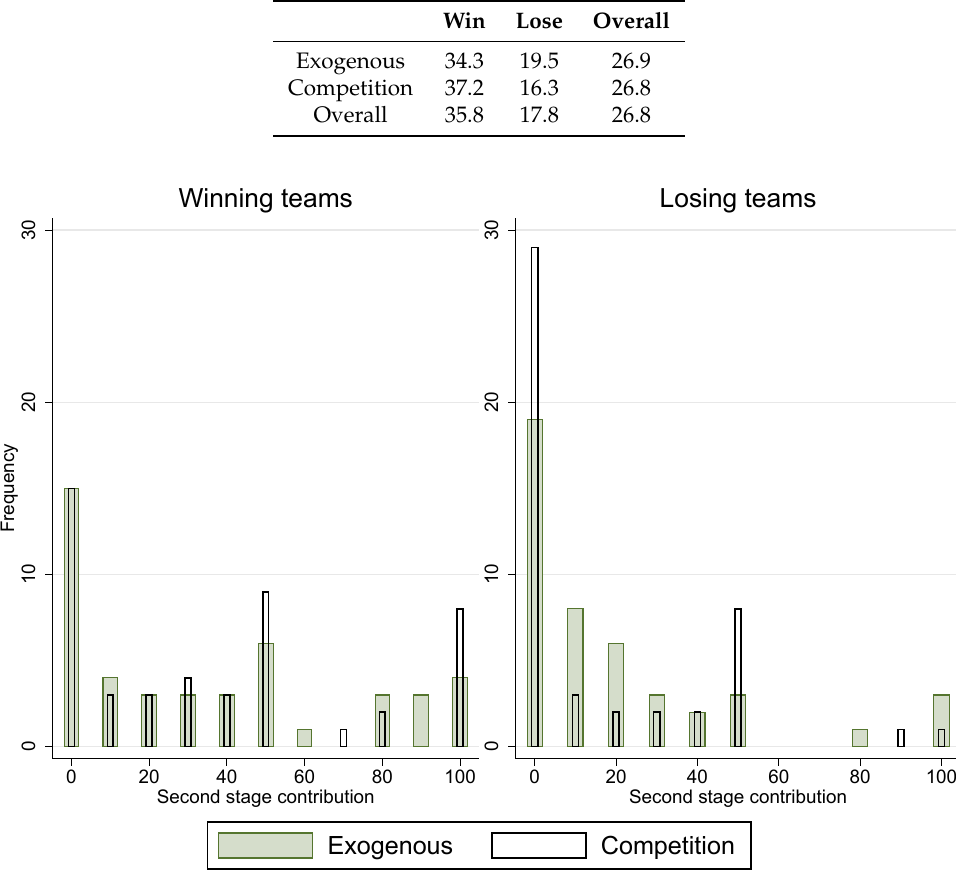
Figure 2. Individual contribution to the team